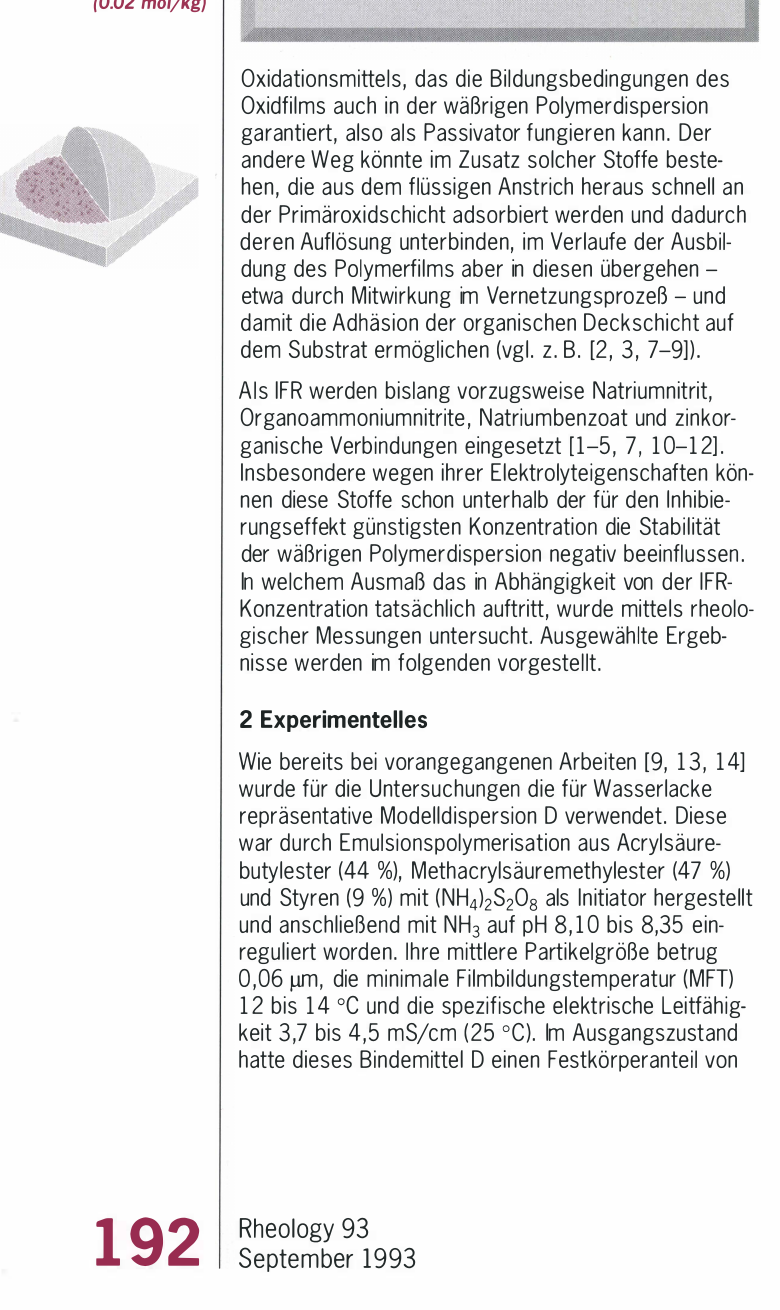
Abb. 1: Schubspannungsgesteuerte FlieiJ-und Viskositiitskurven fur die Modelldispersion D c (Probe 1} bei 25 a 1; 3: ohne Zusatz;